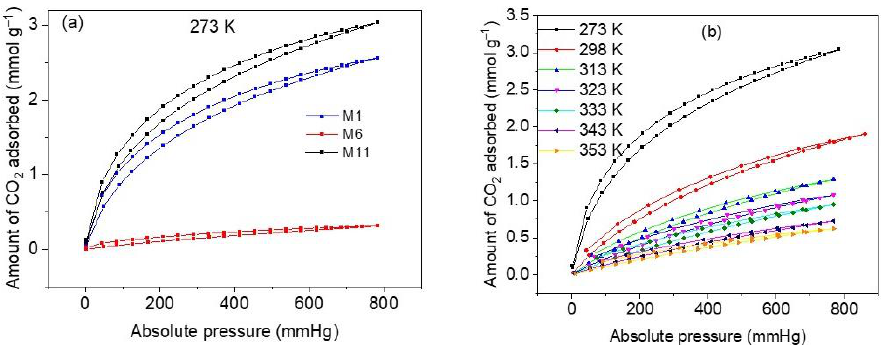
Figure 8. ( a ) CO 2 adsorption capacities on samples M1, M6 and M11 of CoHCFs at 273 K; ( b ) CO 2 adsorption isotherms at 273 – 353 K, on sample M11 of CoHCFs.